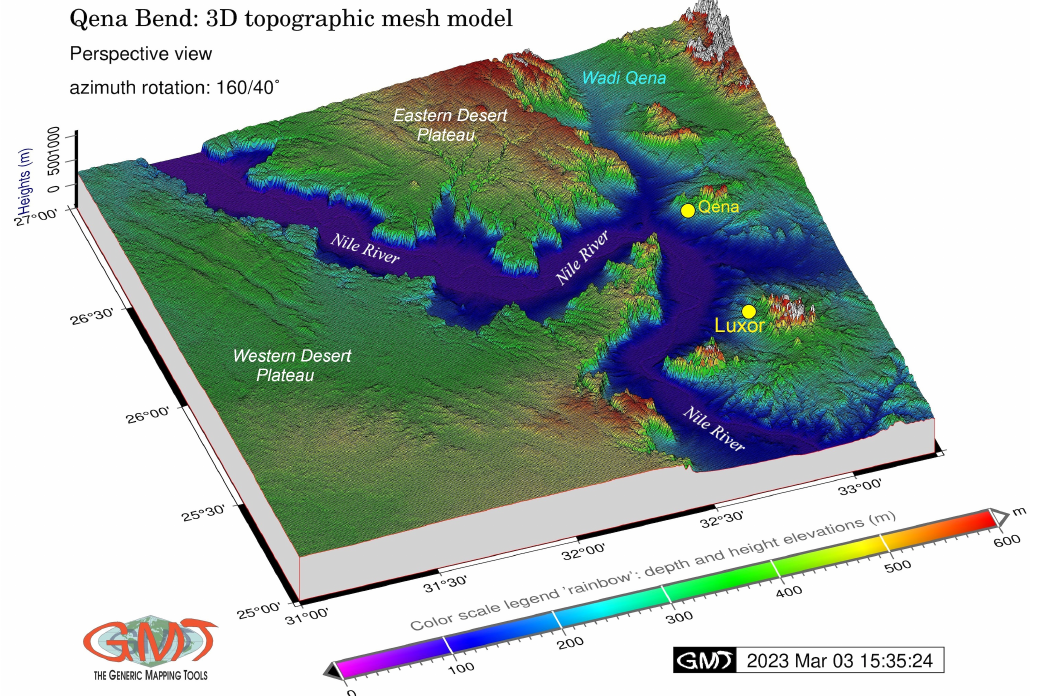
Figure 3. Enlarged fragment of the 3D perspective view of Qena Bend, Nile River, Upper Egypt. Software: GMT v. 6.1.1. Data source: GEBCO/SRTM. Cartography source: